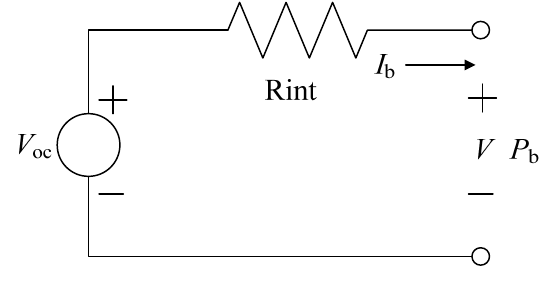
Figure 4. Power battery R int